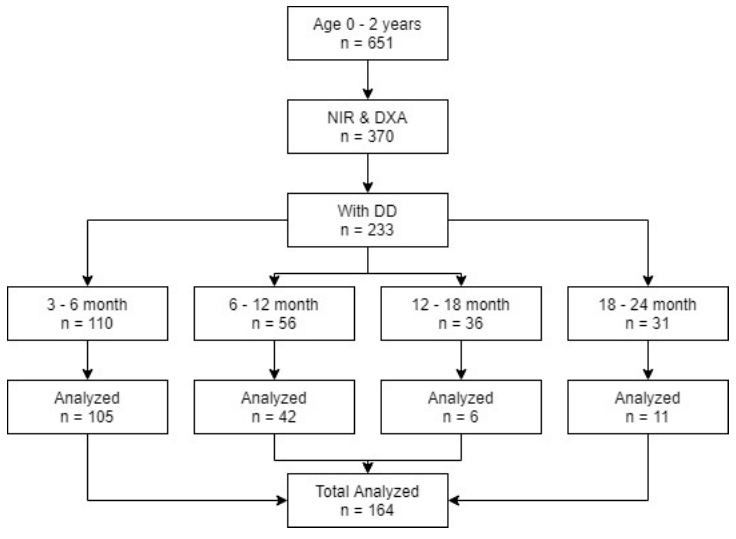
Figure 1. Recruit flow chart.